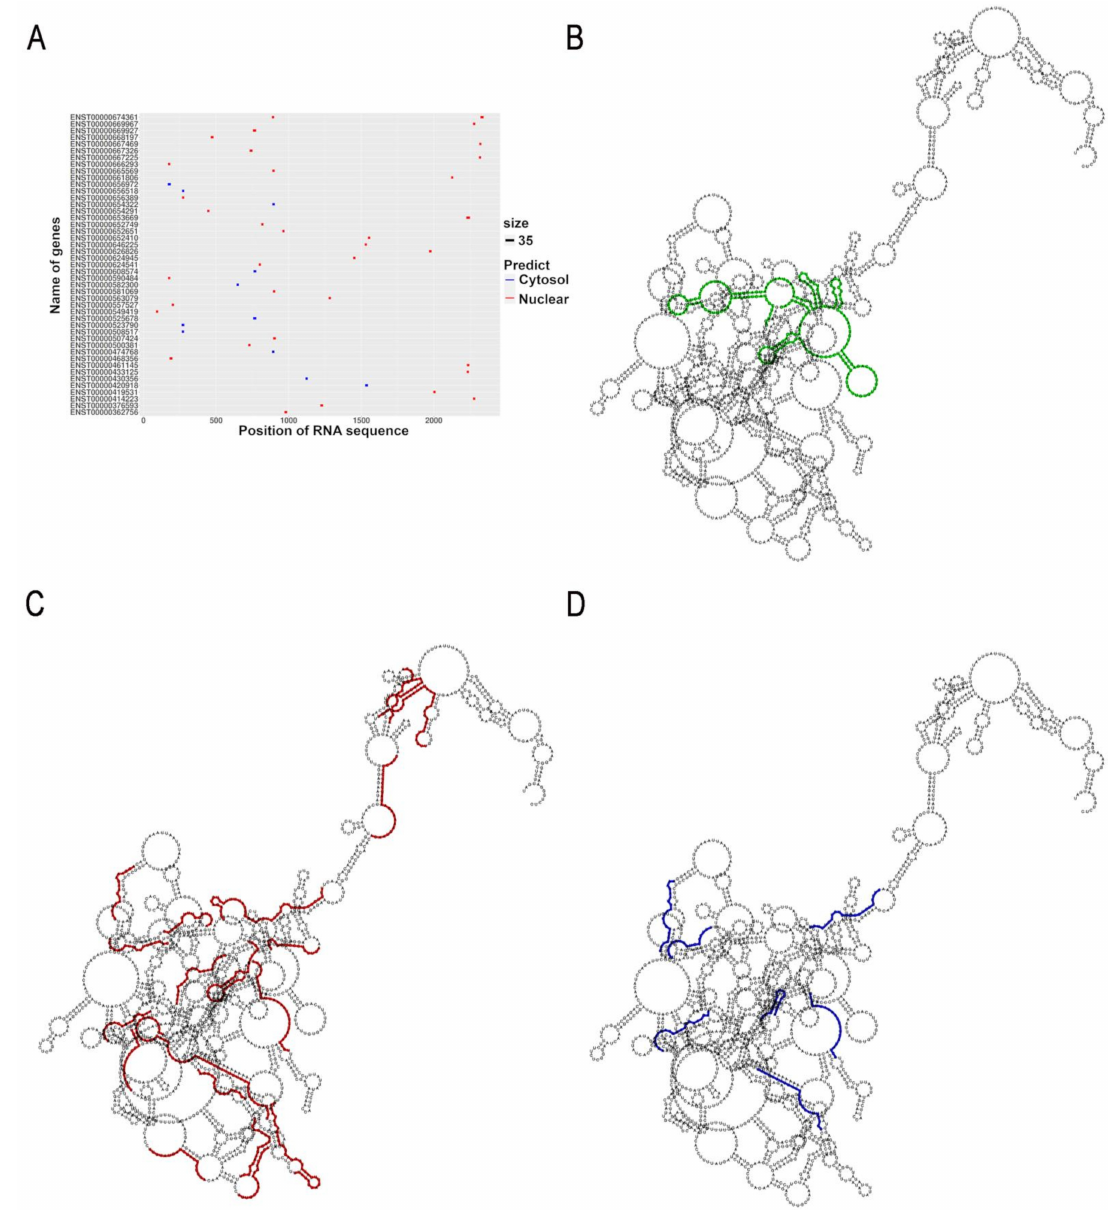
Figure 2. ( A ) Plot of the distribution in the uc.8+ sequence of the predictive genes for the nuclear and cytosolic localization by deep machine learning analysis. ( B ) Predicted secondary structure representation of the whole uc.8+, in green the ultraconserved region. ( C ) Sequences associated with a nuclear localization (in red). ( D ) Sequences associated with a cytosolic localization (in